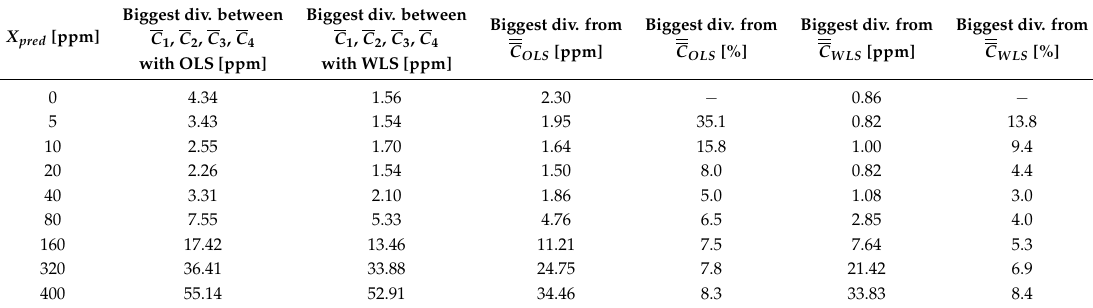
Table 12. Data of the results in Figures 15 and 16, containing the predicted concentration, biggest deviation between all four OiW monitors for each concentration and each calibration method, and biggest deviation from C for each concentration and each calibration